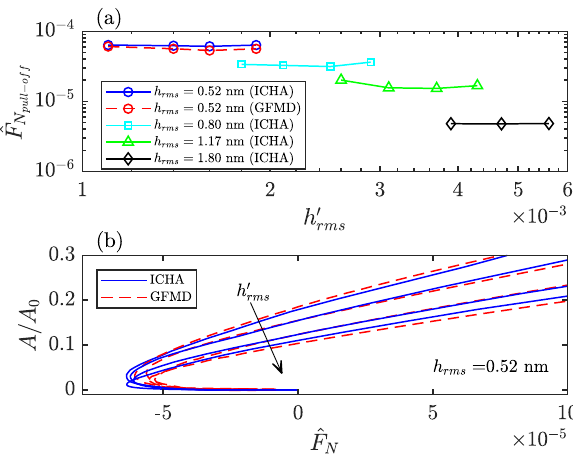
Figure 2: The dimensionless pull-off pressure (taken as the modulus of the minimum value of the normalized applied pressure ˆ F function of the surface rms slope h (cid:48) ent values of the rms roughness amplitude h the predicted area vs. load results with the numerical GFMD data extracted from Figure 19 by Ref.